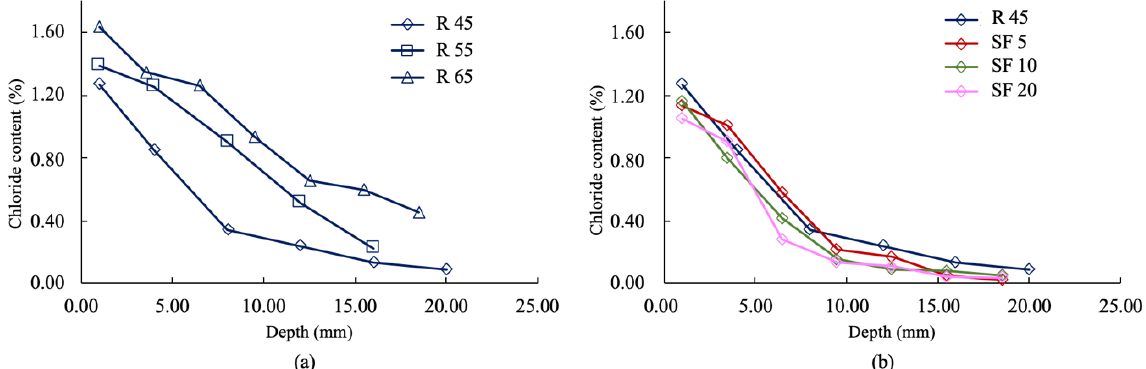
Figure 7. Chloride profiles obtained through potentiometry: (a) influence of the w/b ratio; (b) influence of the silica fume